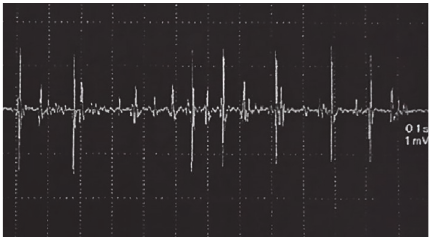
Figure 4: The transferred vastus lateralis muscle underwent volun- tary contraction according to electromyography at 6 postoperative months.